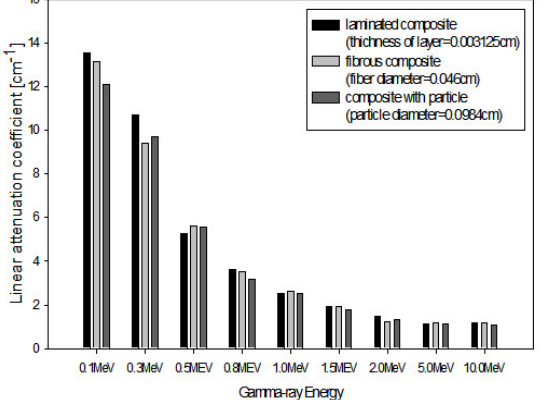
Figure 18. Linear attenuation coefficient of PE/lead composites according to composite structure.